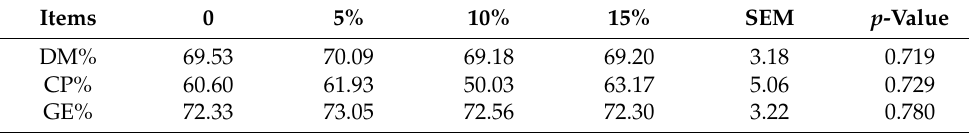
Table 5. Effects of FPFF on tract apparent digestibility of DM, CP, and GE (40–42